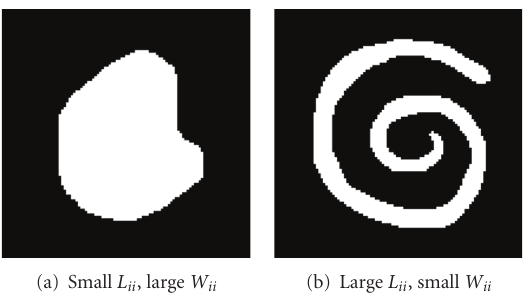
Figure 5: Example shapes for analyzing scale behaviour of saliency